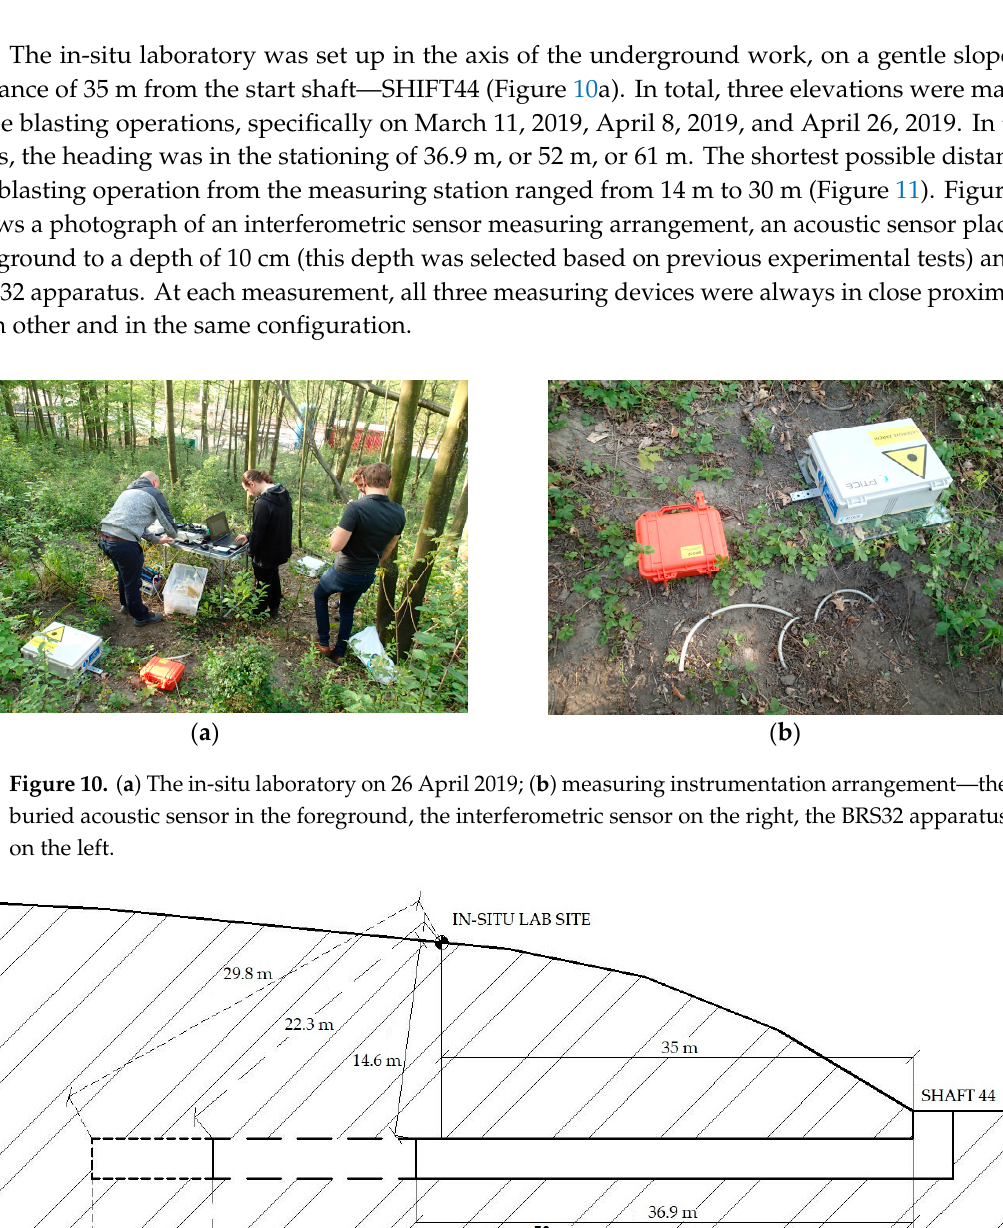
Figure 9. A drilled and partially charged heading.